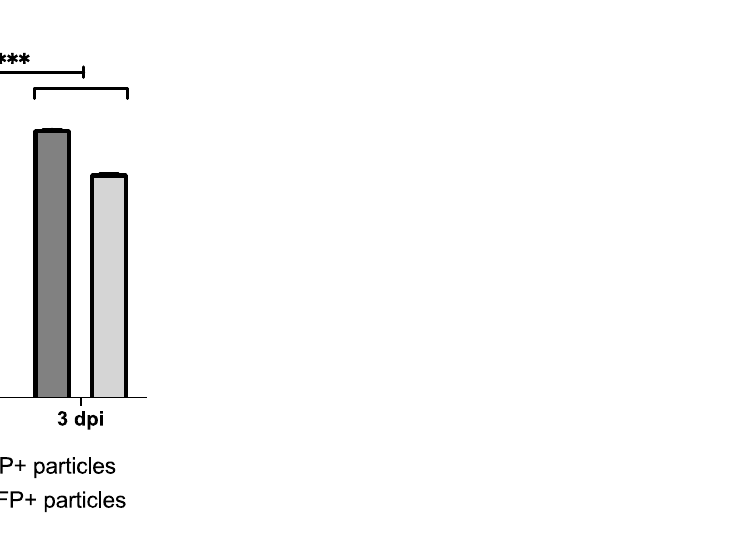
Figure 7. Comparison between Clone 92 supernatants with no induction and 3 days post-induction (3 dpi) by flow virometry: Quantification of flow virometry subpopulations of large particles and total GFP+ particles in each studied condition. Error bars indicate SEM. Significance is indicated by **** and is calculated via two-way ANOVA.